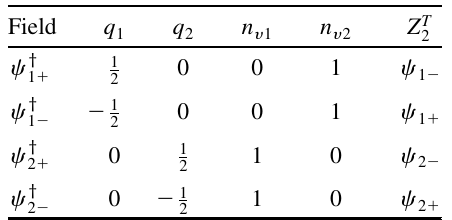
TABLE I. Symmetry properties of the c , c fields. q 1 (cid:2) 2 (cid:2) 1 ; 2 are the charges under the two U ð 1 Þ symmetries associated with b , respectively. n are the vorticities in the phase of b . v 1 ; 2 1 ; 2 1 ; 2 They can also be viewed as the gauge charge for the coupling to the corresponding U ð 1 Þ gauge fields. The last column gives the transformation under time